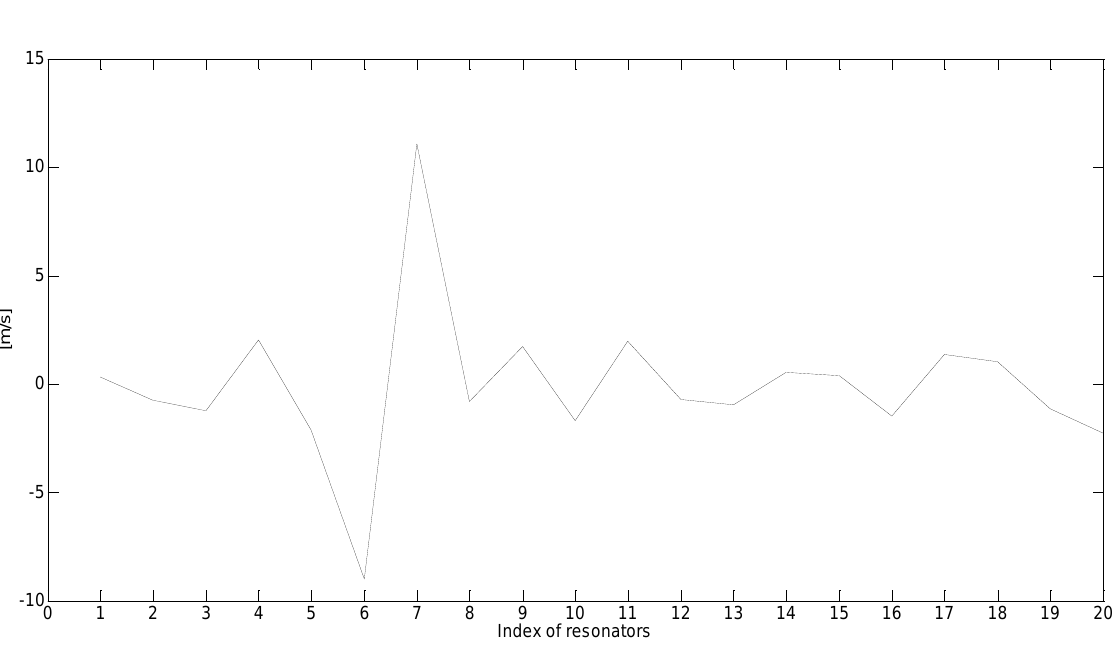
Fig. 2. Stiffness focus, diag ( A ) versus the mode index.